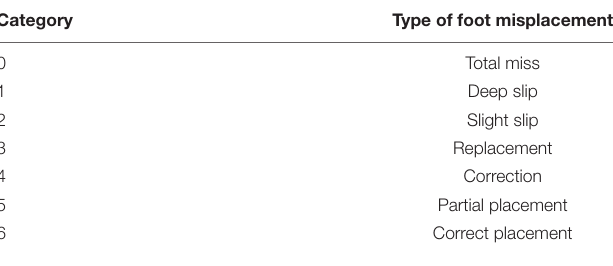
TABLE 1 | Rating scale for foot placement in the LRWT.